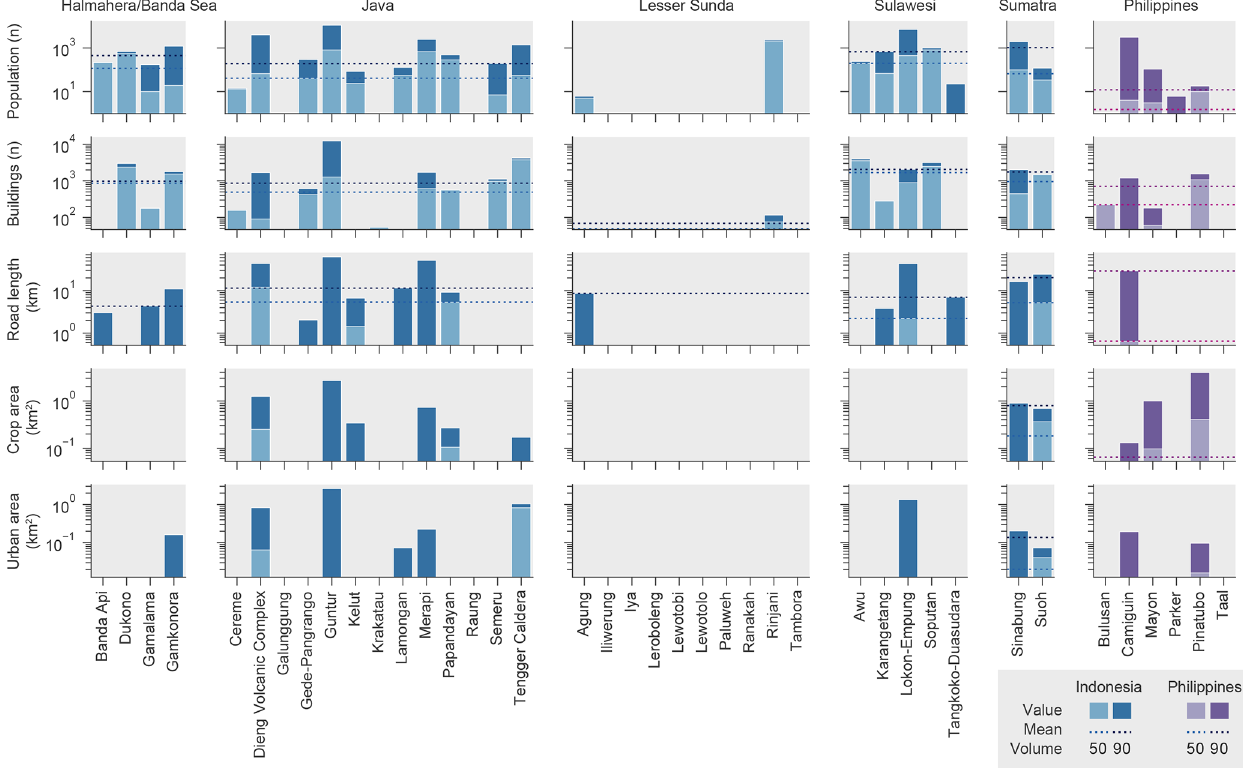
Figure 8. Exposure to inundation from dome collapse PDCs summarised per region and exposure type. The hazard is extracted for a conditional exceedance probability of occurrence of 50% and considers a 990m buffer around the flow footprint. Overlying (not stacked) bars illustrate the variability in exposure with the initial flow volume (with the top of the bar representing exposure for that volume) and dotted lines the median for the